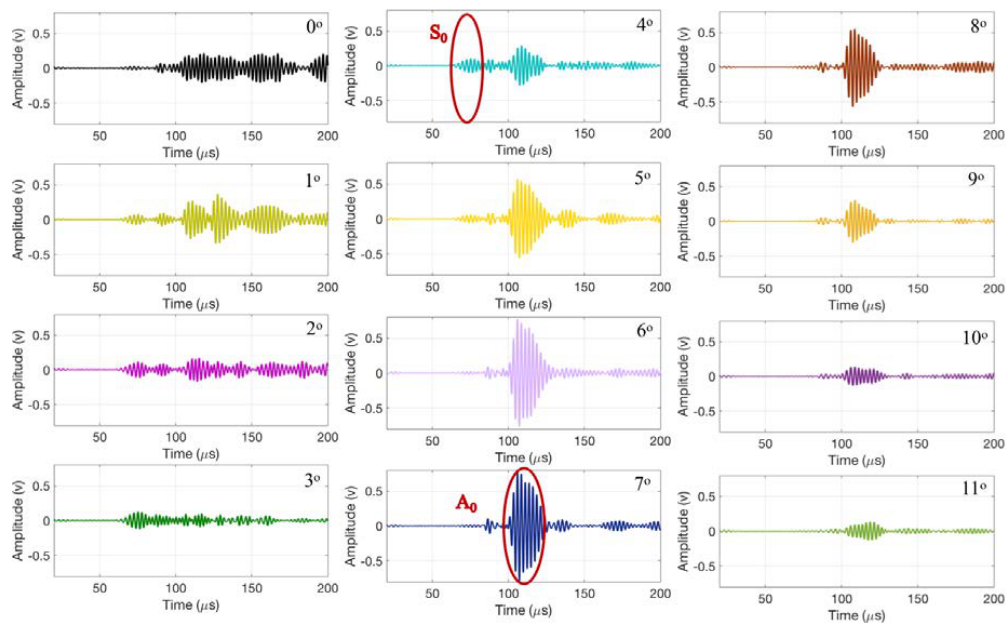
Figure 5. The recorded waveforms corresponding to receiver angles of